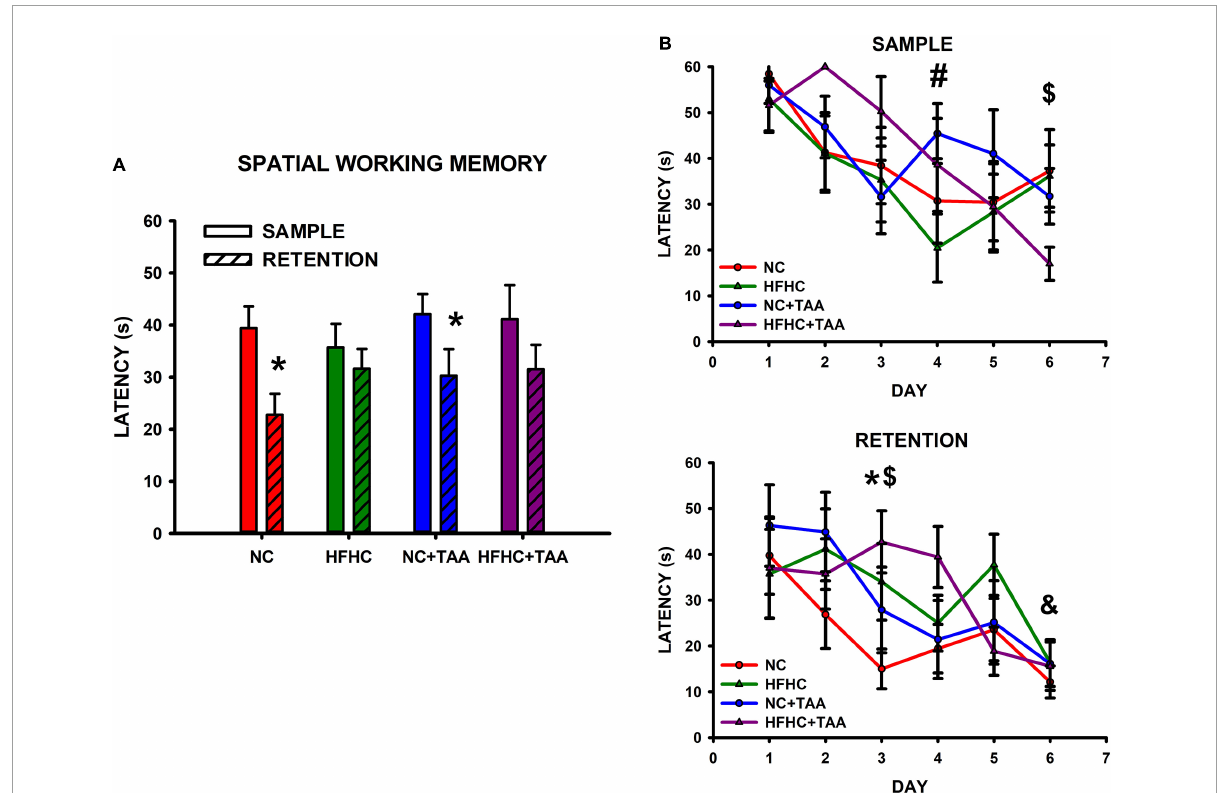
FIGURE12 Spatial working memory test. (A) Bars charts (mean ± SEM) represent the average latency in sample and retention trials that was compared through paired t -test (* comparison with its respective sample; * p < 0.05). The NC and NC + TAA groups remembered the position of the platform in the retention trial, whereas HFHC and HFHC + TAA were not able to. (B) Scatter plots (mean ± SEM) represent latencies that were compared through a two-way repeated-measures ANOVA (group x day) within sample and retention. No differences were found between groups; however, a delay in the acquisition of the affected groups was detected. In the sample trials, the HFHC group displayed significant differences in latencies on day 4 compared to those on day 1 (# p < 0.05), whereas HFHC + TAA showed reduced latencies on day 6